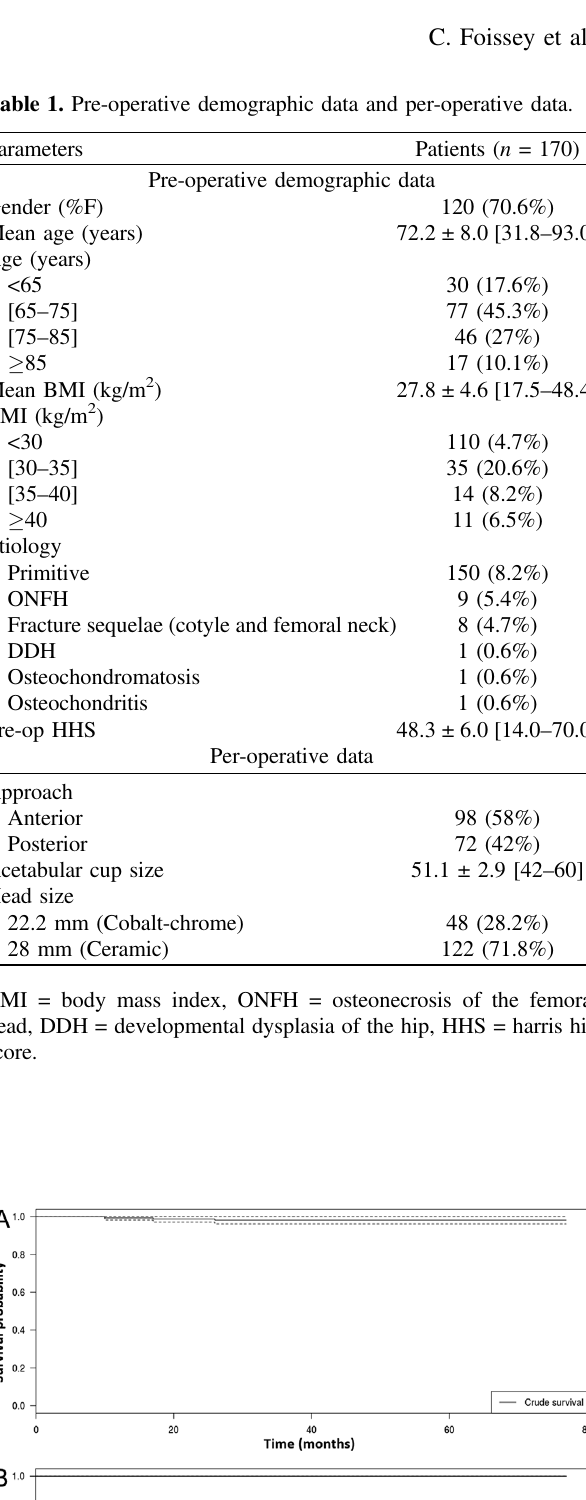
Figure 4. Cup positioning according to safe zones. 90.6% (154/170) of the cups were in the safe zone in the frontal plane, 86.5% (147/170) in the transversal plane, and 80% (136/170) in both